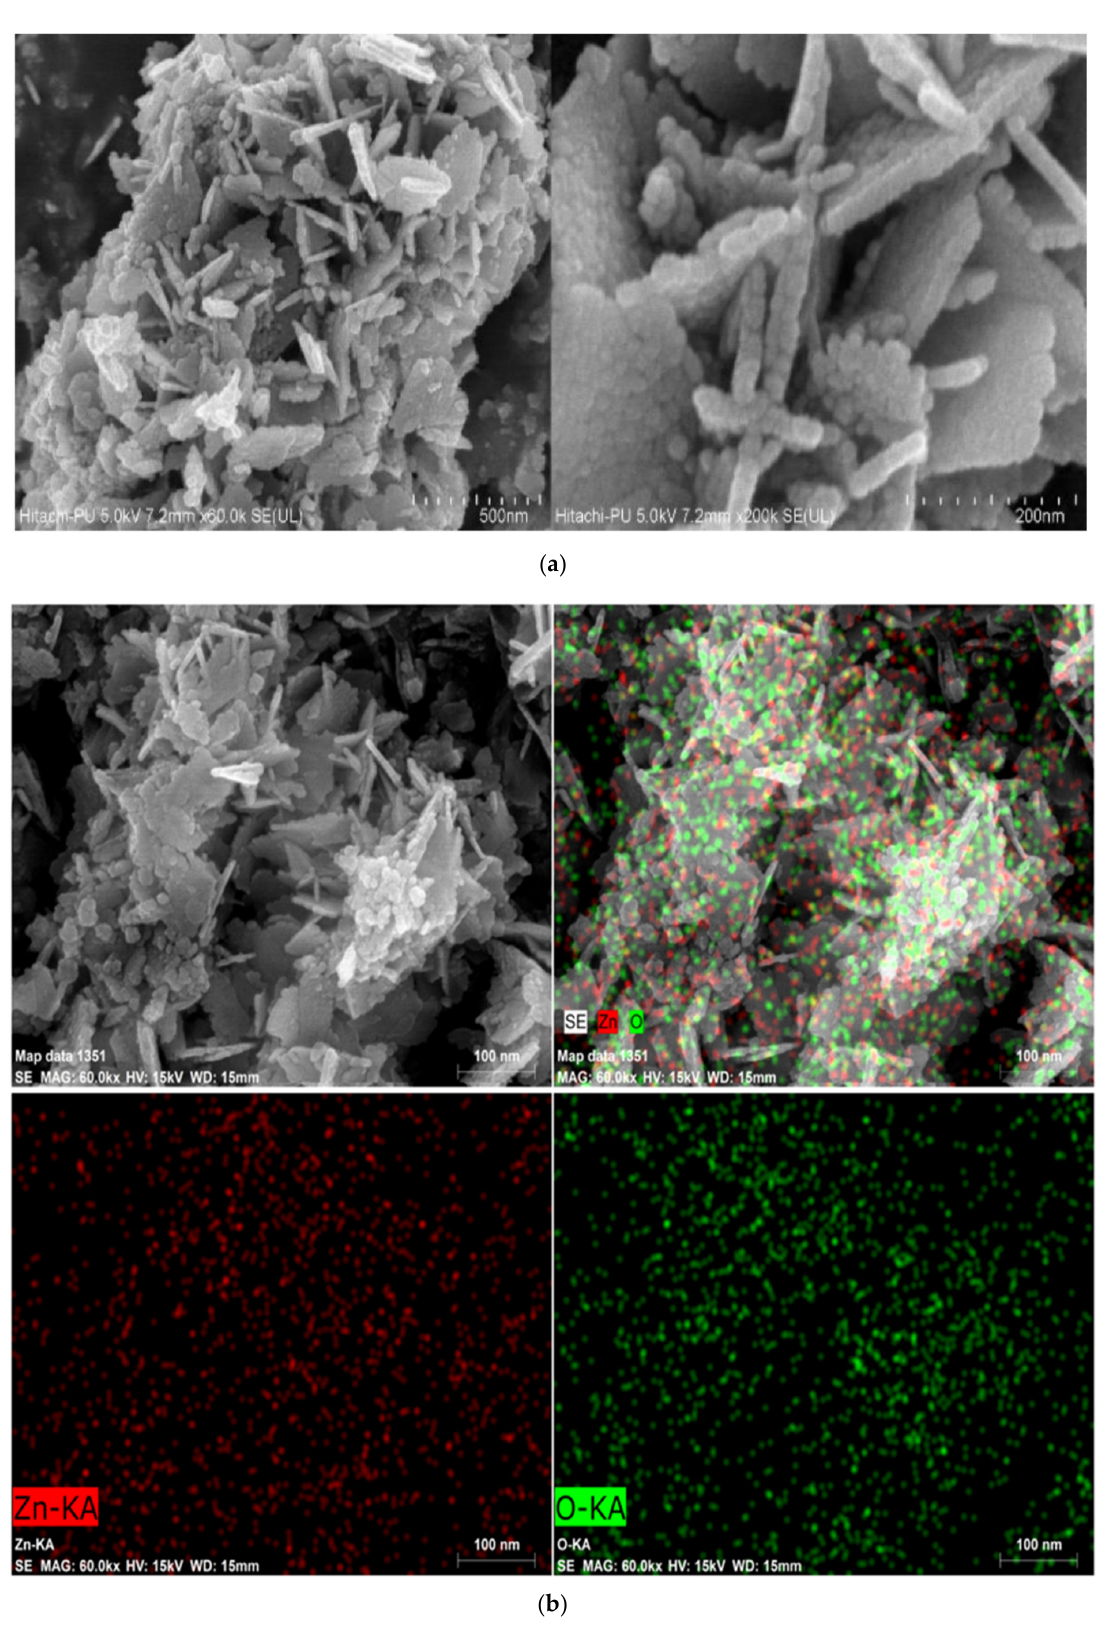
Figure 5. FE-SEM micrographs ( a ) and Elemental mapping ( b ) of ZnO-NPs.